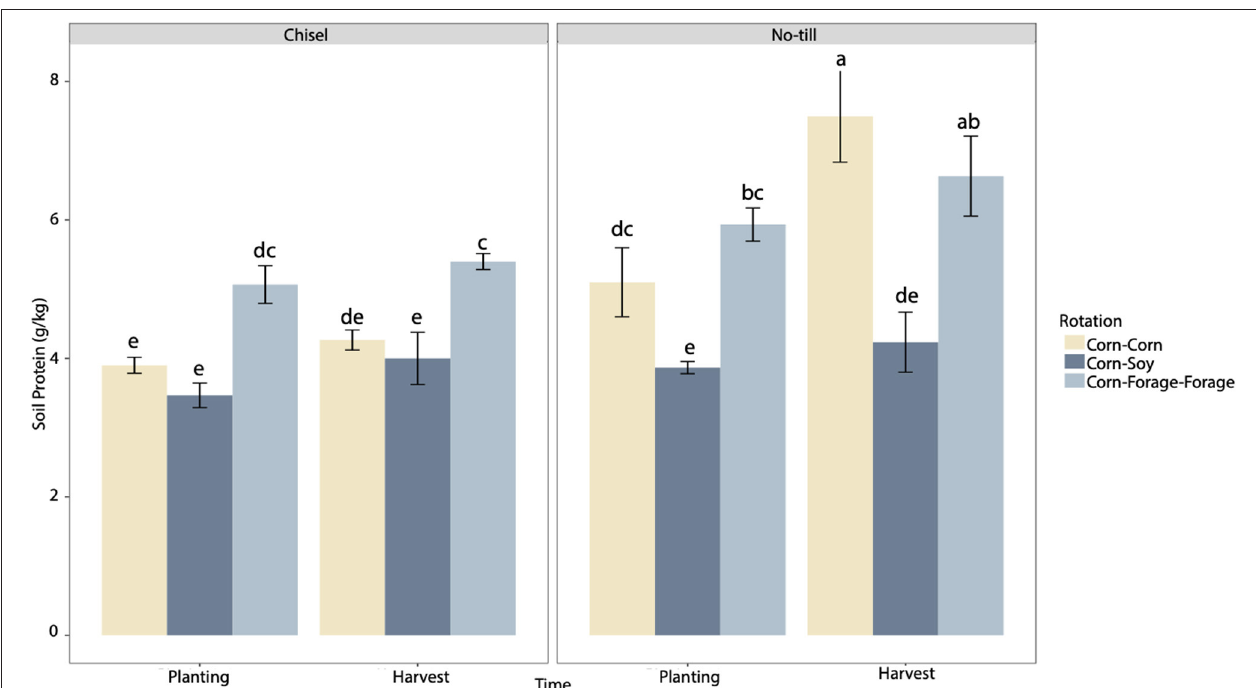
FIGURE 1 | Soil protein (g kg − 1 ) of three different crop rotations (corn–corn, corn–soy, corn–forage–forage) under no-till and chisel till treatments during two sample time points: planting (May 2020) and harvest (October 2020) ( n = 3). Error bars represent one standard error of the mean. Means separation reflected by lower-case letters represent significant differences at p < 0.05 across all systems and time